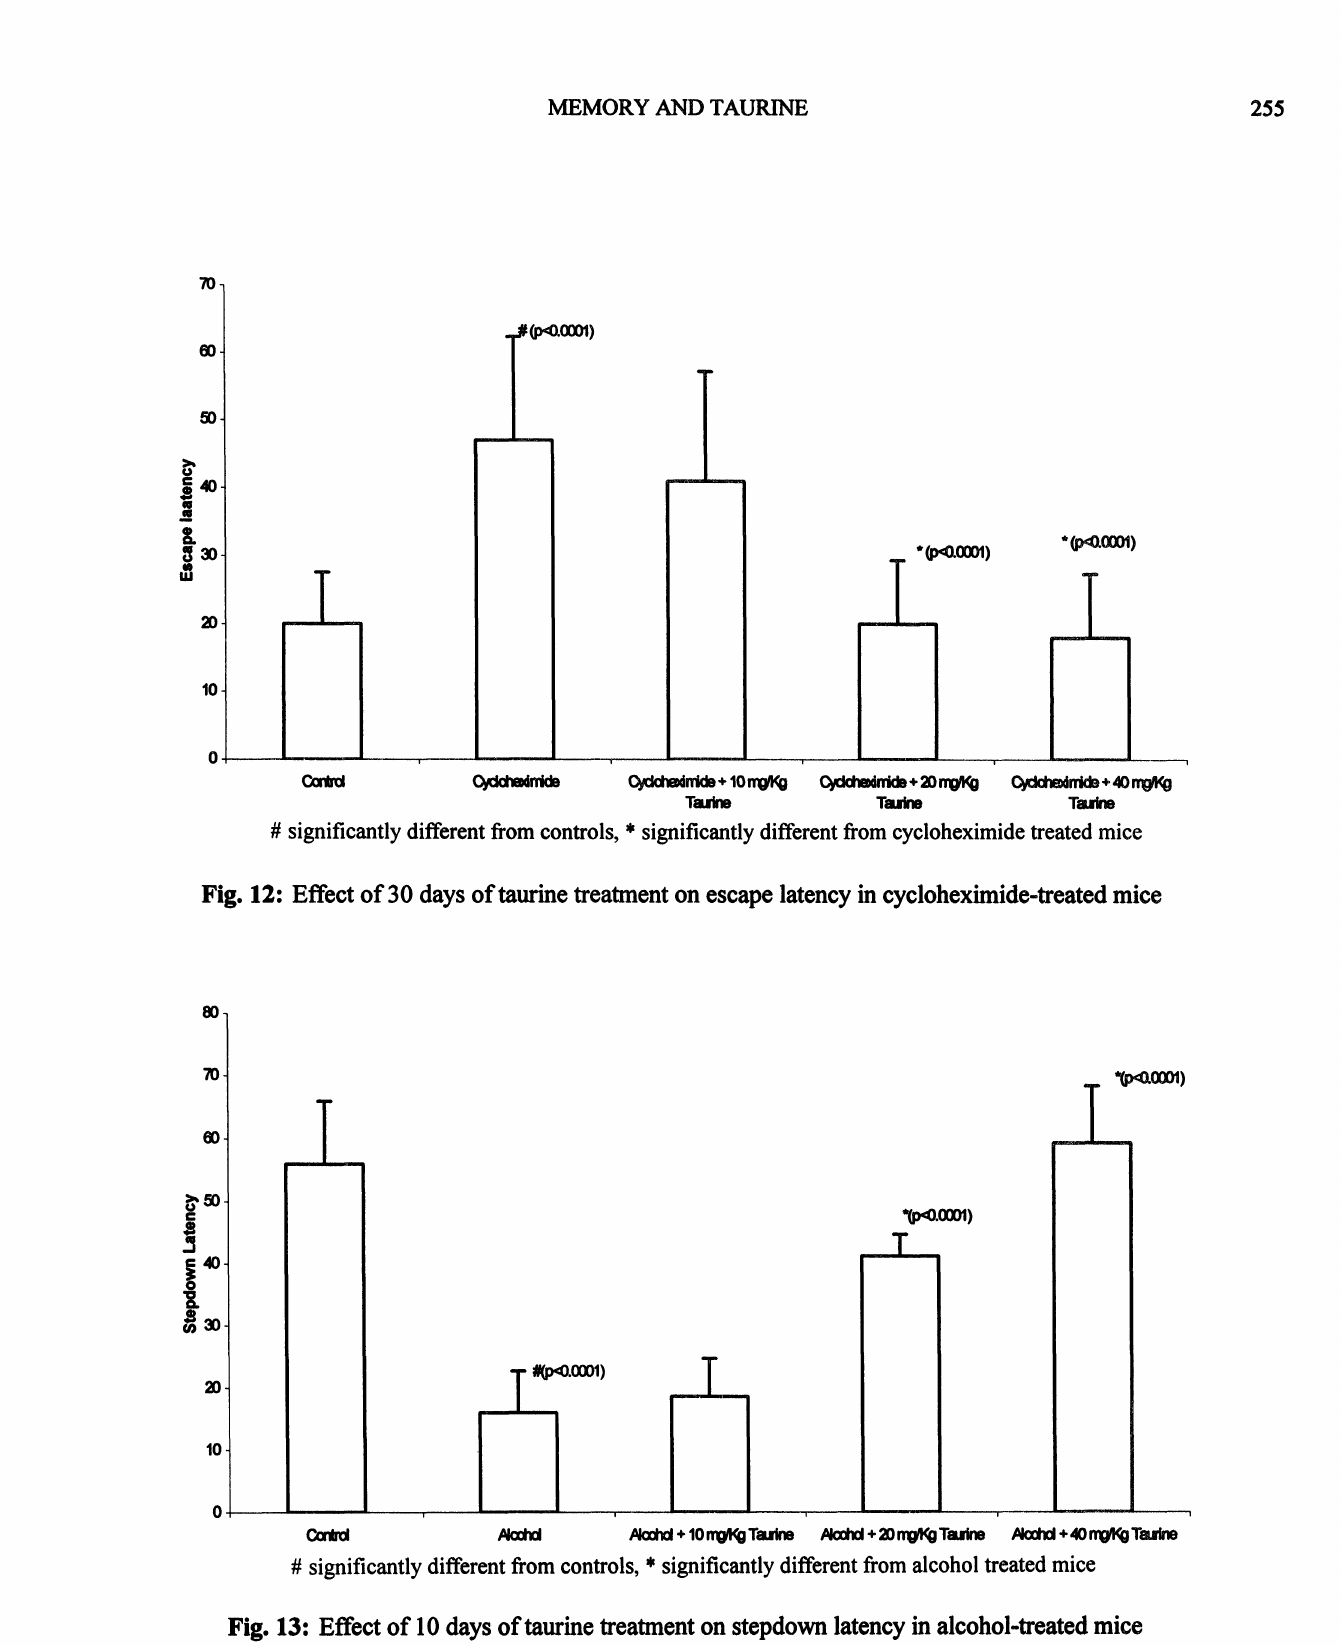
# significantly different from controls, * significantly different from alcohol treated mice Fig. 13: Effect of 10 days oftaurine treatment on stepdown latency in alcohol-treated